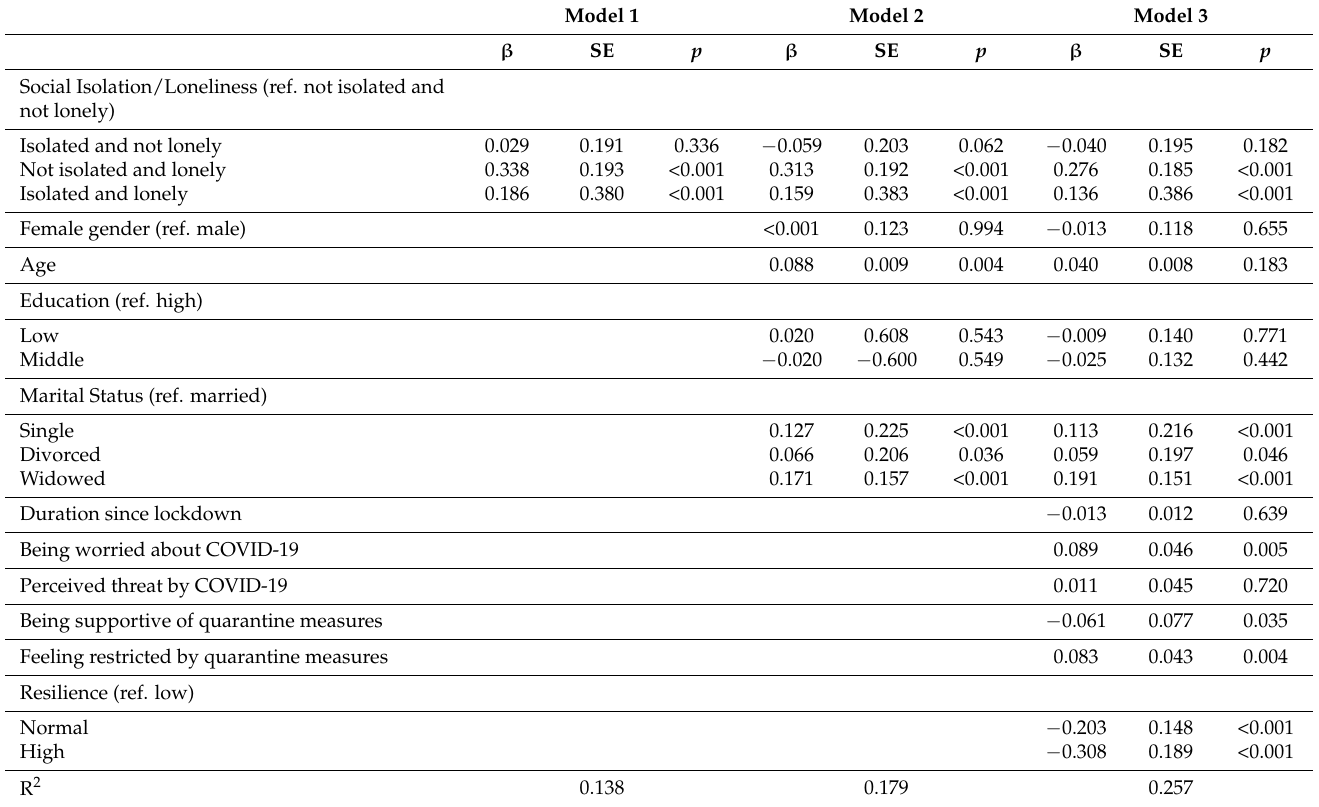
Table 3. Results of multiple regression analyses: associations of social isolation, loneliness, sociodemographic factors, attitudes towards COVID-19, and resilience with depressive